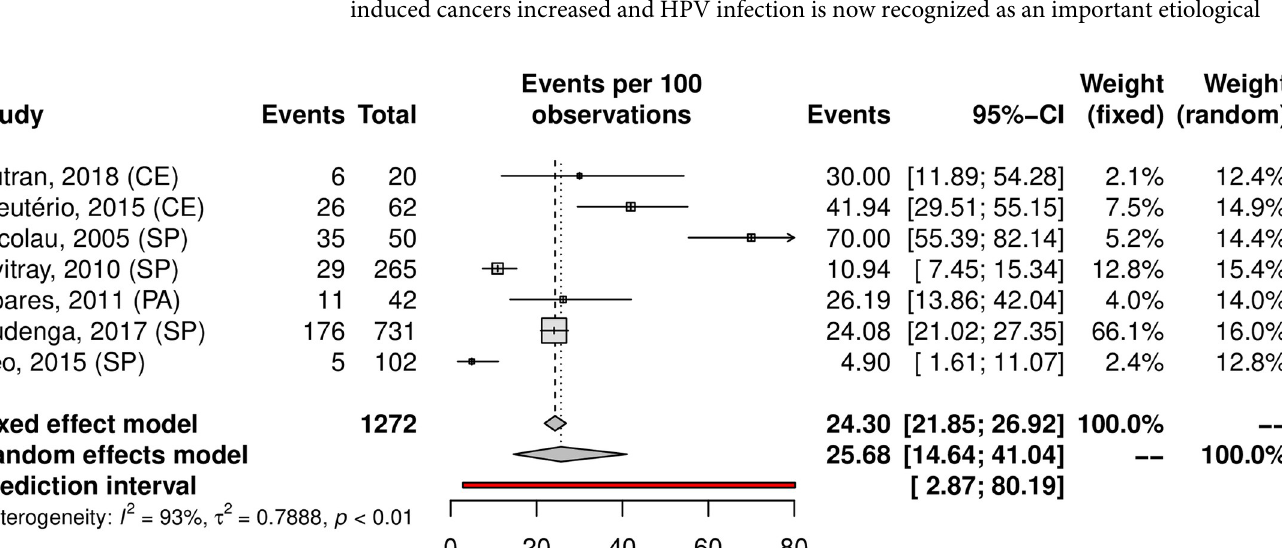
PLOS ONE | https://doi.org/10.1371/journal.pone.0229154 February 21,